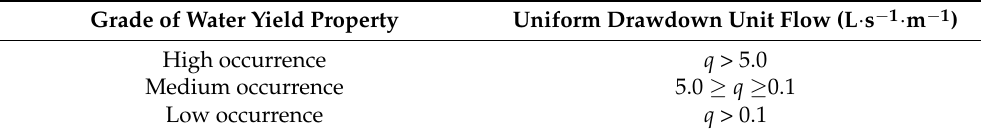
Table 3. Classification standard of water abundance of overlying aquifer